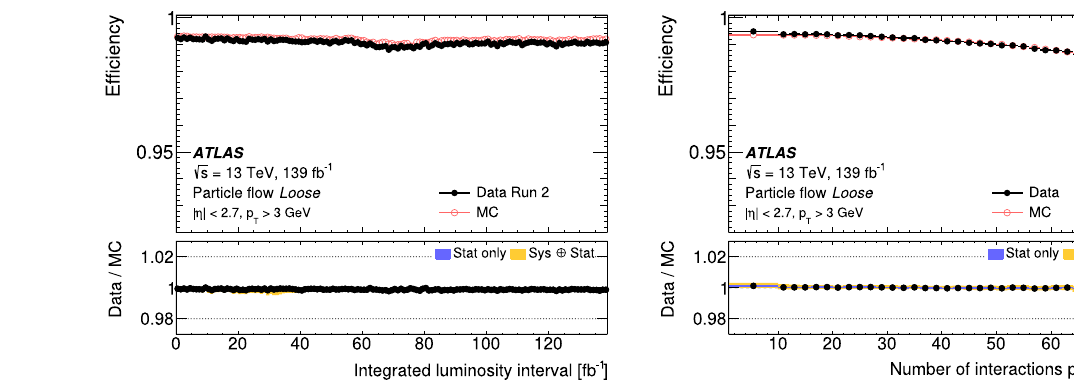
Fig. 24 Efficiency for the PflowLoose isolation criteria measured in Z → μμ events as a function of the integrated luminosity interval (left) and the actual number of interactions per bunch crossing (right) formuonswith p T > 3GeV.Intheleftploteachdatapointcorresponds